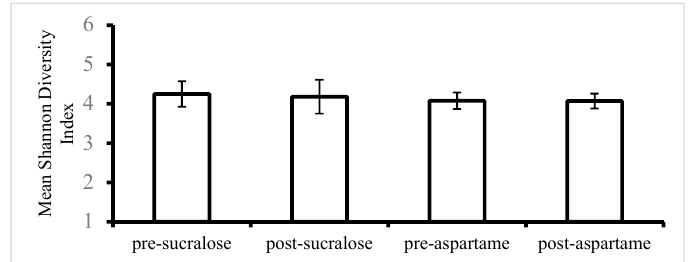
Figure 2. Change in the mean Shannon diversity index after sucralose or aspartame treatment ( n = 17). Between-group comparison by the linear mixed effect model. Values are expressed as the means ± standard error of mean (SEM).